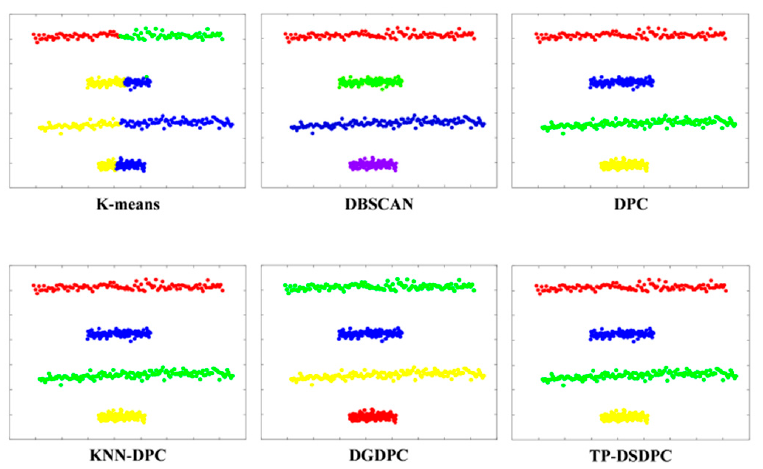
Figure 11. Clustering results on Fourlines. The clustering results of the Aggregation dataset are displayed in Figure 12. The TP-DSDPC has the best clustering performance, while other algorithms are less efficient. As for the last R15 dataset, which is displayed in Figure 13, all of the algorithms can identify different clusters. However, K-means and DBSCAN have some clustering errors, because many normal points on the boundary of the clusters are also recognized as noise points.